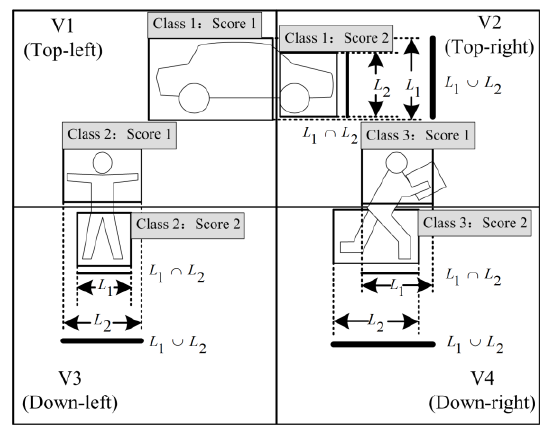
Figure 4. Evaluation of adjacent boundary lines in multiple views.